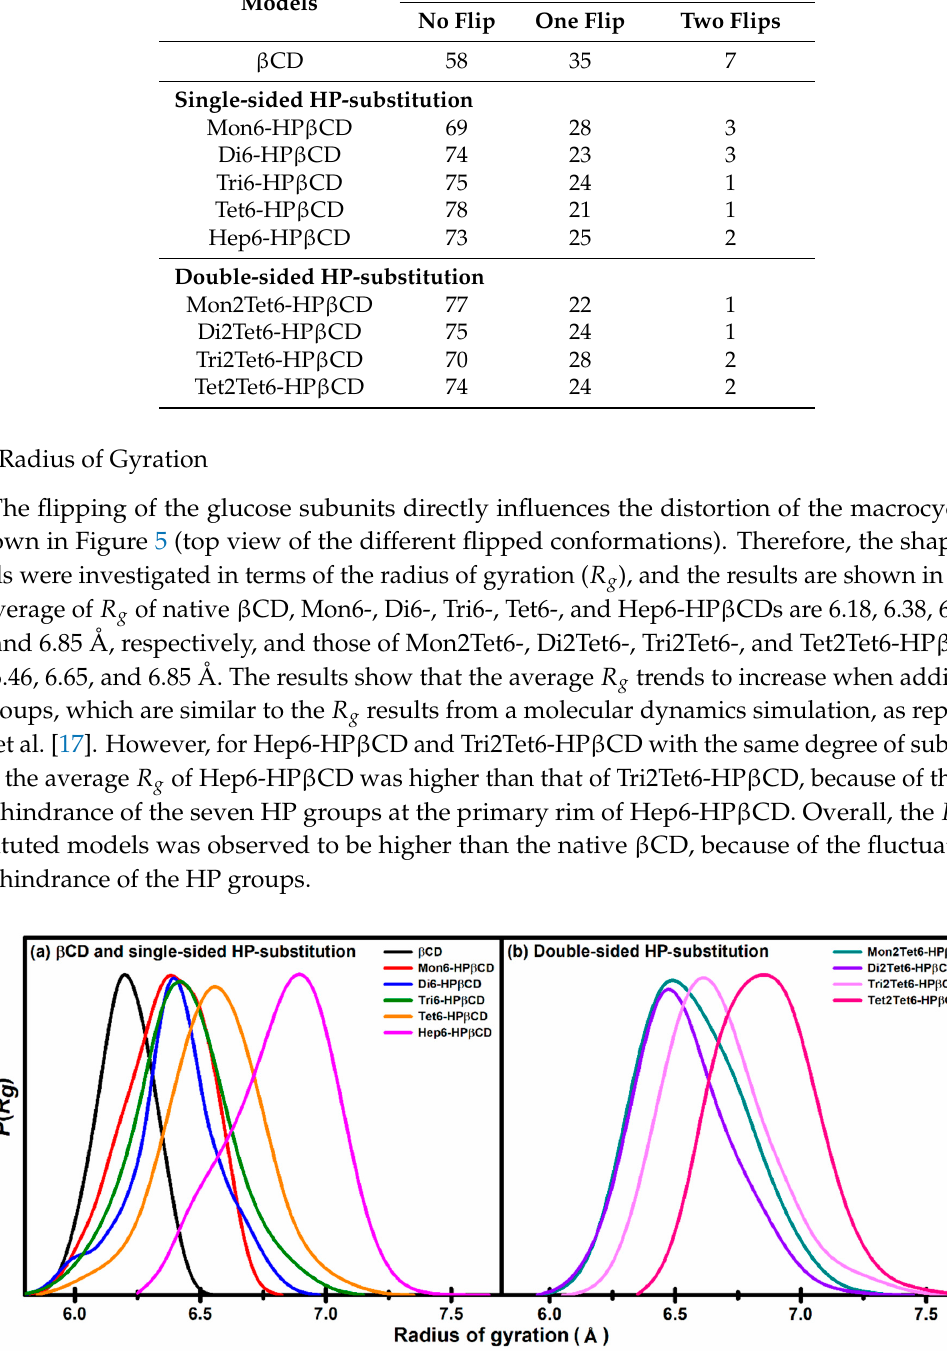
Table 2. The probability of different numbers of flip glucose subunits in β CD and HP β CDs, using the flip angle parameter, θ (i) [C6 (i) –C2 (i+1) –C6 (i+1) ] at 300K (criteria: values higher than 90 degrees).